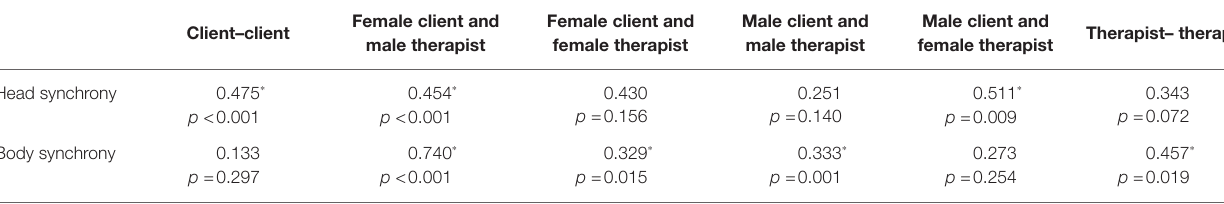
TABLE 1 | Intraclass correlations of the head and body synchronies for each dyad.